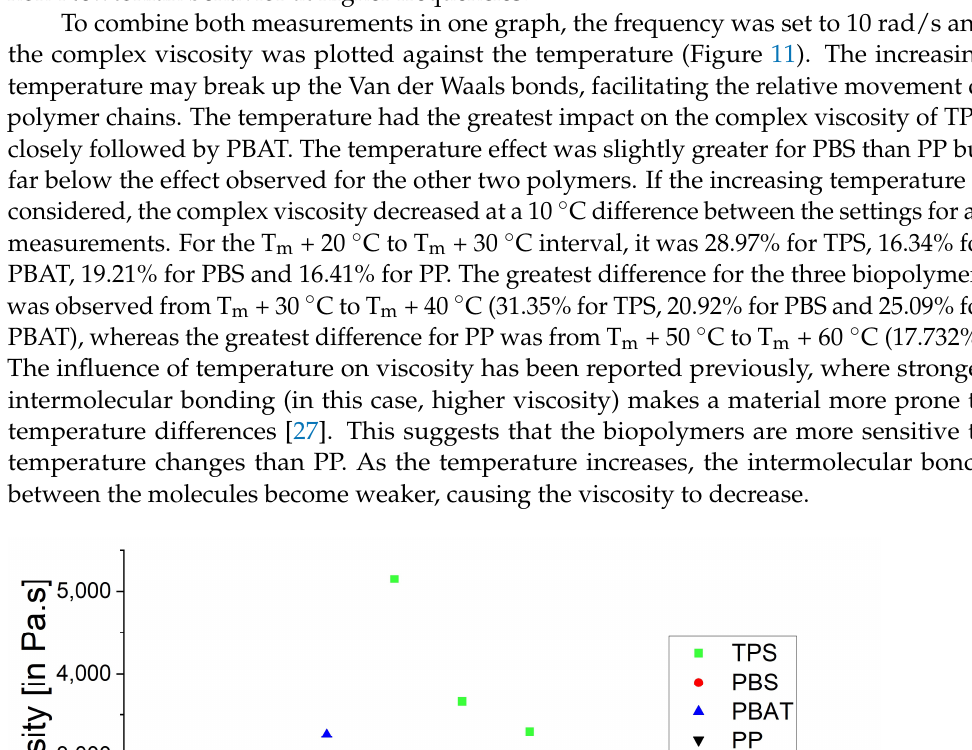
Figure 10. Rheological temperature sweep for TPS.